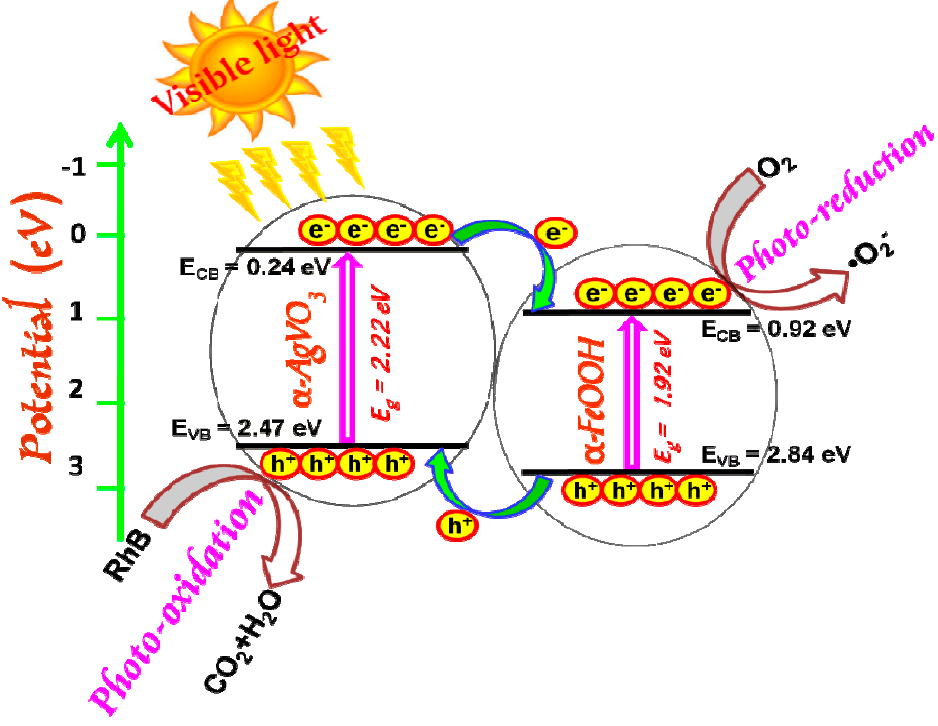
Figure 10. A proposed charge-transfer mechanism for the increased degradation of RhB using α -FeOOH/ α -AgVO 3 nanocomposite photocatalysts under visible-light illumination.